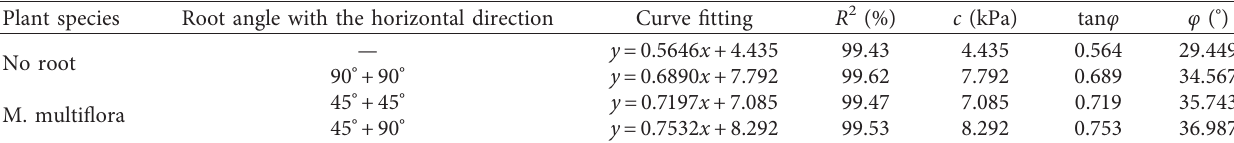
Table 3: Laboratory results of the direct shear